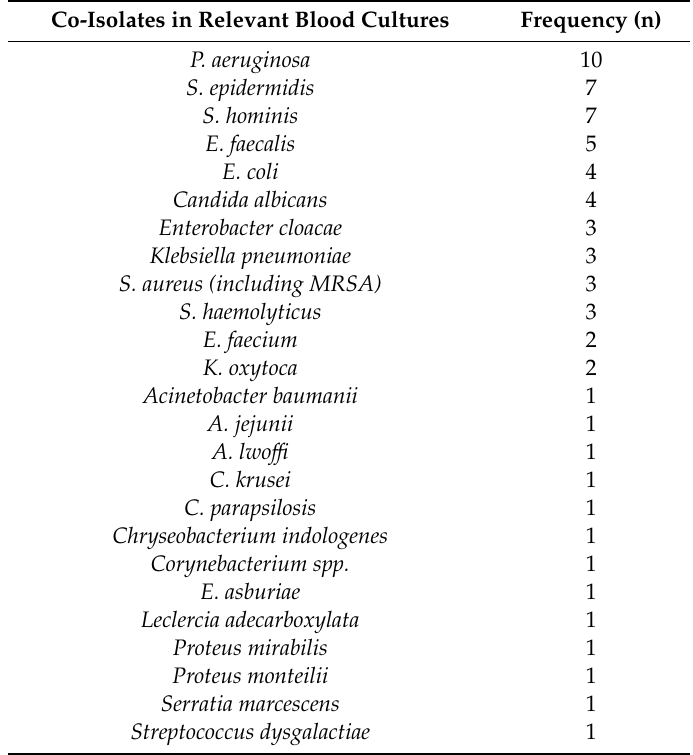
Table 1. Bacteria co-isolated with S. maltophilia in bacteremia, 2008–2017. Co-Isolates in Relevant Blood Cultures Frequency